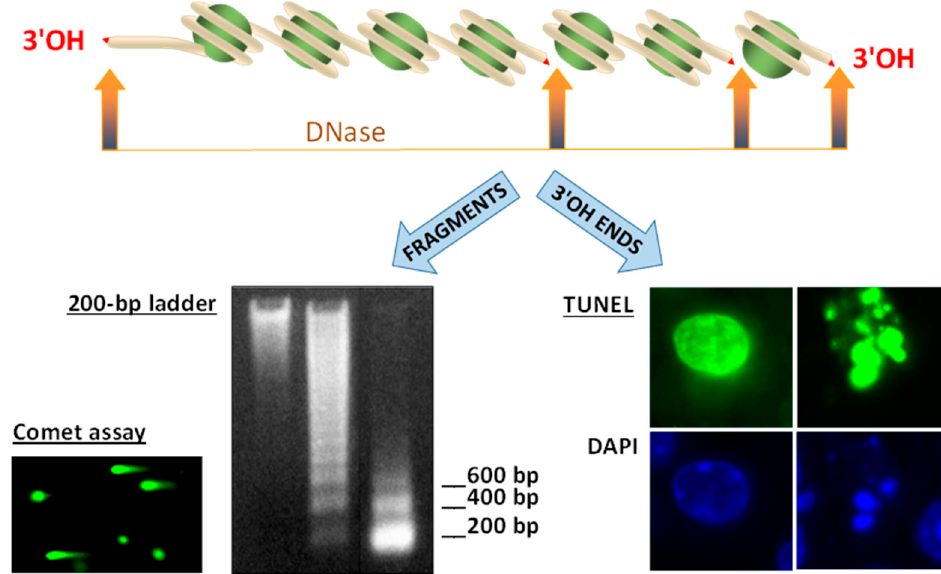
Figure 2. Three main DNA fragmentation assays: DNA ladder and comet assays vs. Table 200. bp apart from each other. The resulting double-stranded DNA fragments are seen as a nucleosomal 200-bp ladder in agarose gel. Comet assay is a single-cell variant of the same method, in which comet-like images represent DNA degraded in a dead cell, while dots without comets are formed by DNA from live cells. TUNEL labels 3 ′ OH DNA termini in DNA within whole and fragmented nuclei.